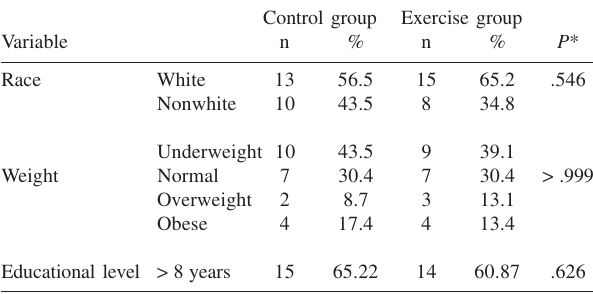
Table 2 - Distribution of the 46 patients studied (control and exercise groups) regarding the results of race and weight during pregnancy (HCFMUSP, November 2003 to December 2004).